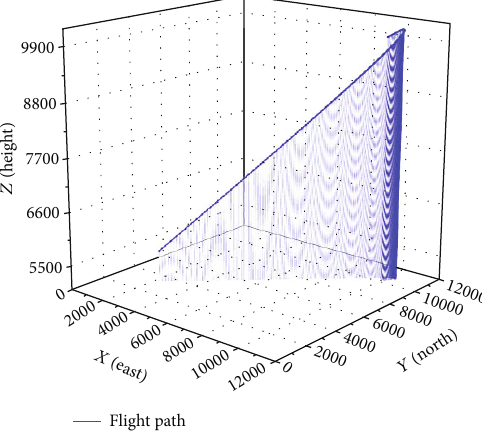
Figure 8: Trajectory without azimuth mutation (uniform Table 4: Uniform variable motion fi lter initialization conditions.